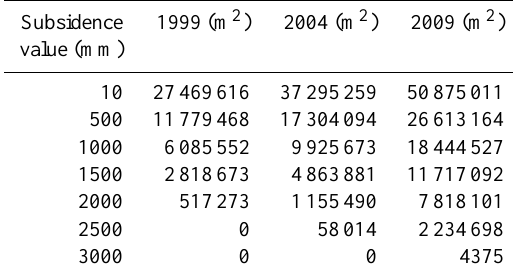
Table 2. The area statistics of mining subsidence numerical simu-